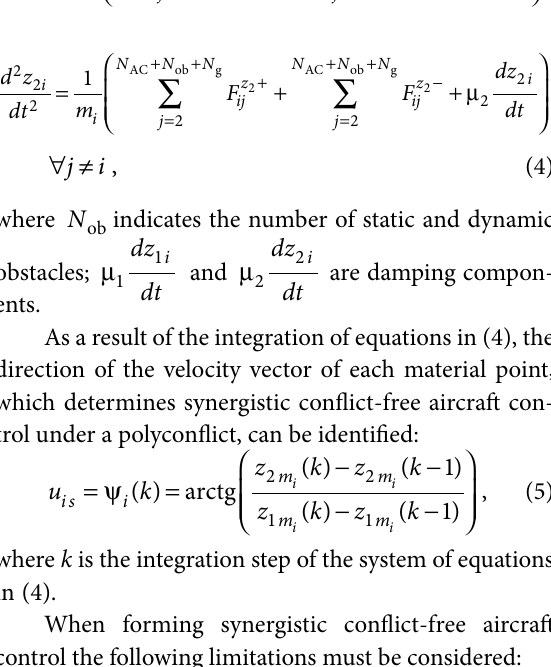
Fig. 1. Block diagram of synergistic aircraft